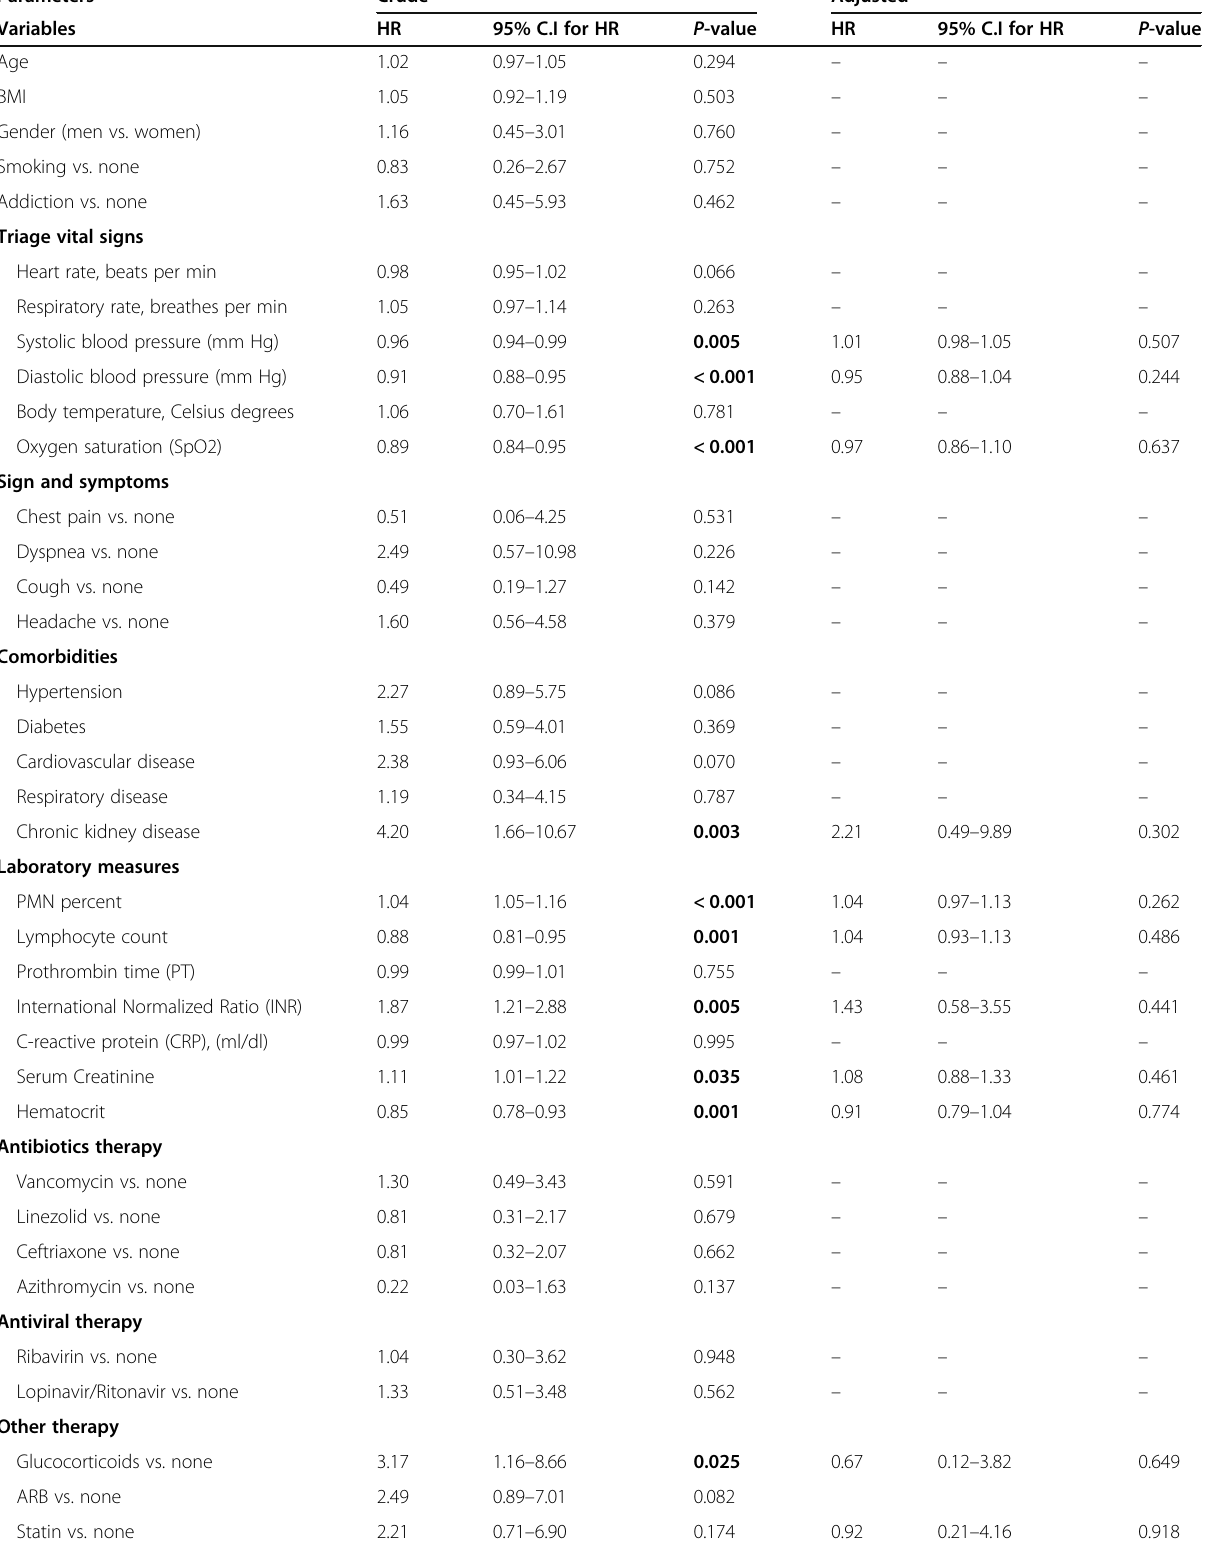
Table 2 Data analysis using the crude and adjusted Cox regression